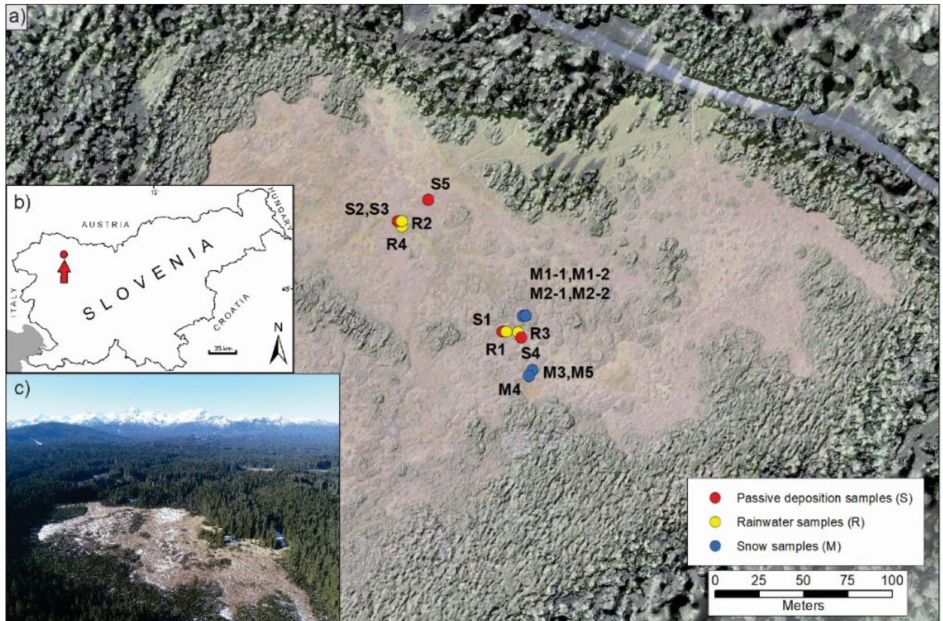
Figure 1. ( a ) Sampling locations in the middle and northwest of the Šijec bog with labelled samples. Orthophoto and topographic map was created with unmanned aerial vehicle (UAV). ( b ) Location of the Pokljuka plateau in Slovenia. ( c ) Aerial view of the Šijec bog and the Pokljuka plateau, showing the general topography of the plateau. Red dots marked with S represent Passive deposition samples locations, yellow dots marked with R represent Rainwater samples locations and blue dots marked with M represent snow samples